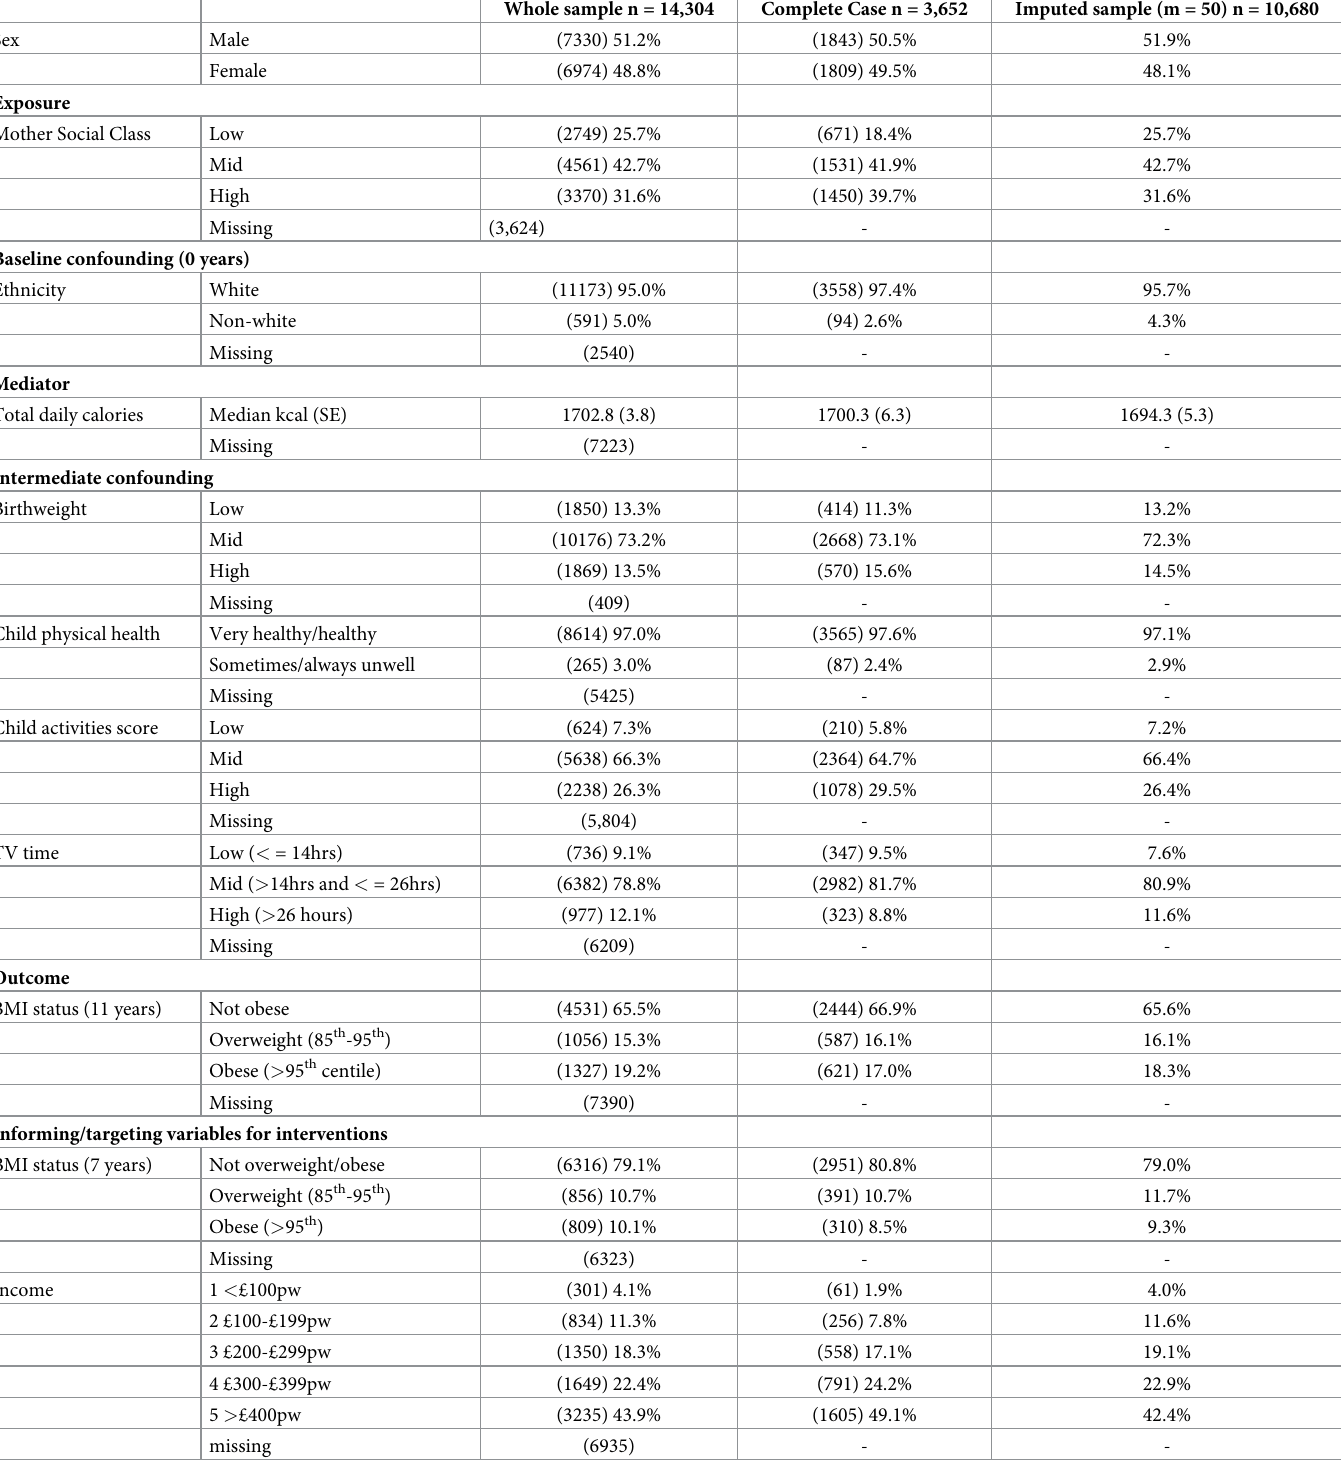
Table 2. Descriptive statistics of ALSPAC across analytical